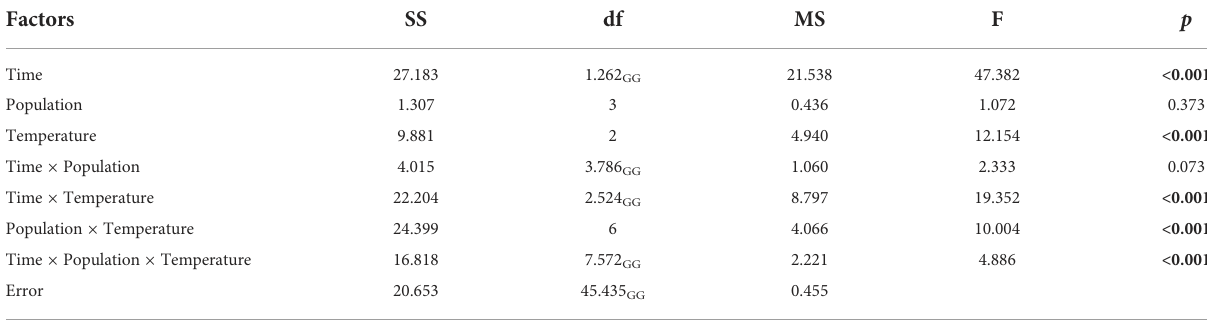
TABLE 4 Three-way repeated measures ANOVA for the effects of population, temperature, and time on the relative reproductive potential of female gametophytes of Laminaria ochroleuca .